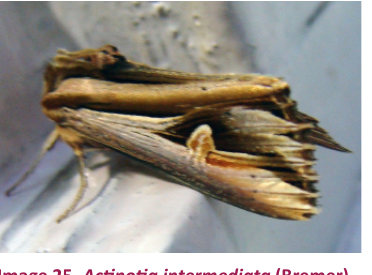
Image 25. Actinotia intermediata (Bremer) (Erebidae)